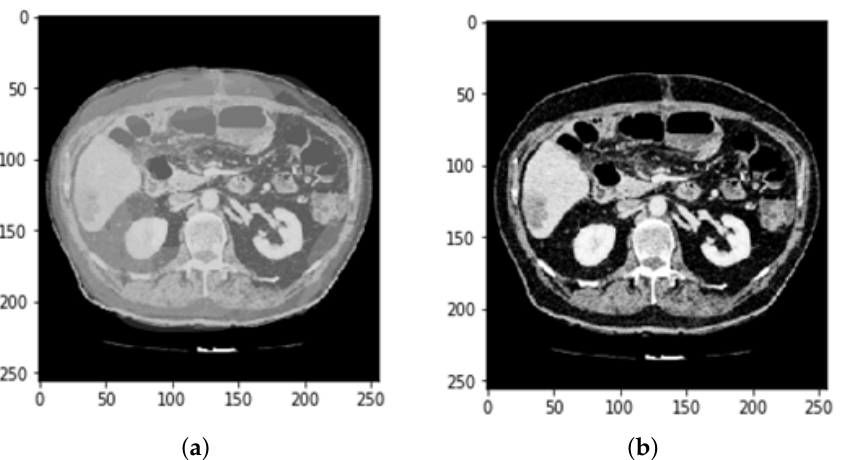
Figure 2. Preprocessing state of CT image ( a ) before Hounsfield unit windowing and ( b ) after HU